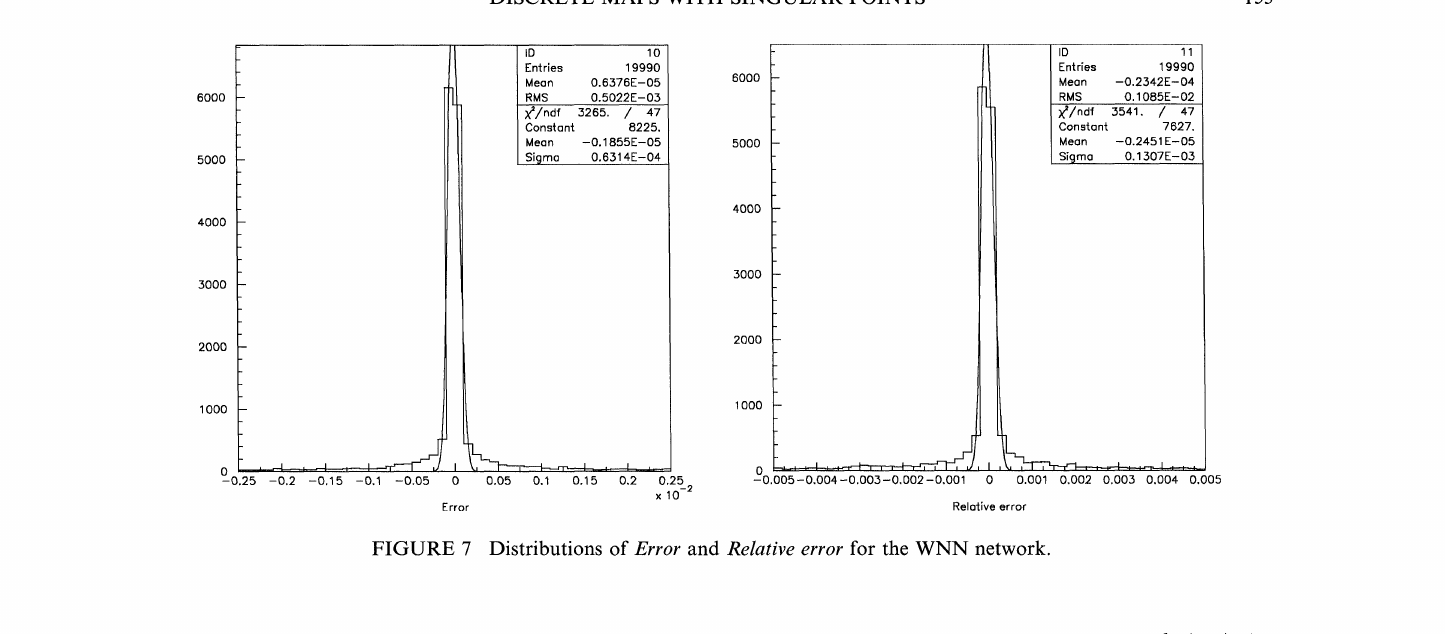
FIGURE 7 Distributions of Error and Relative error for the WNN